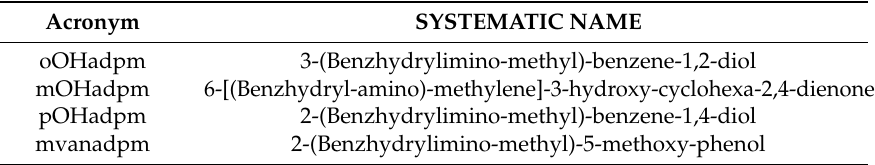
Table A2. Systematic names and acronyms of the compounds reported in this work.